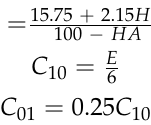
Figure 6. Adhesion output-curves between each tire pattern and soil. (A to F in Figure 6 corre- spond to A–F in Table 2).